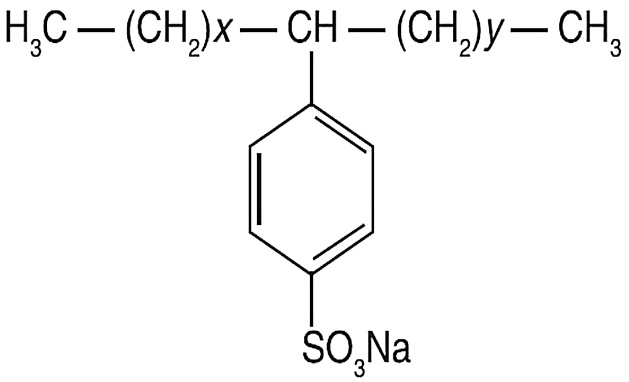
Structure of LAS [33].